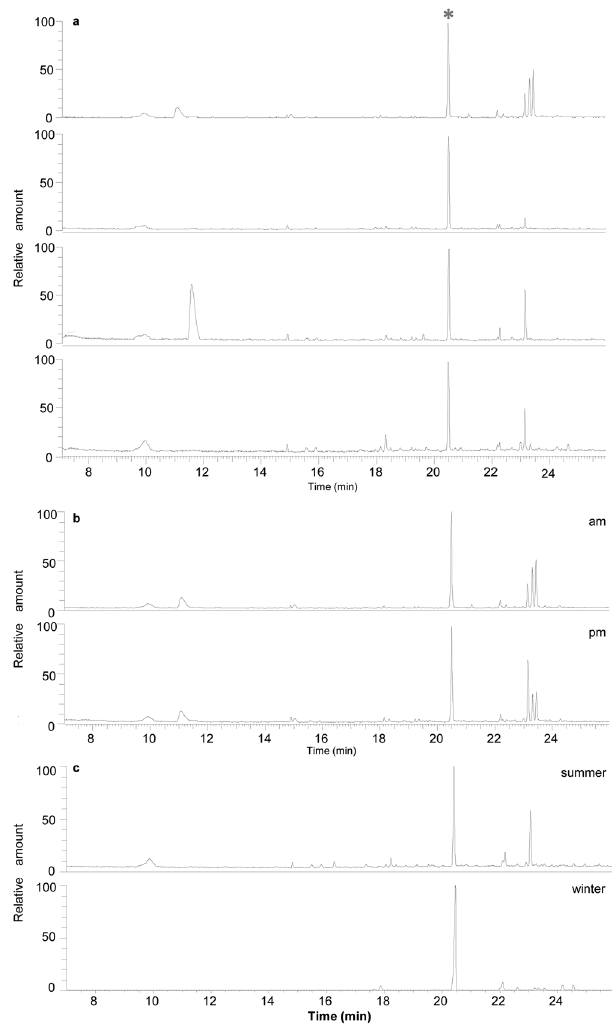
Figure 1. Representative gas chromatographic mass spectrometry separation of volatiles emitted from guava leaves under different conditions: ( a ) VOC emission from leaves in different developmental stages (from top to bottom: flush; young; mature; old); ( b ) VOC emission from flushes at different time points; ( c ) VOC emission from old leaves in different seasons. * , β